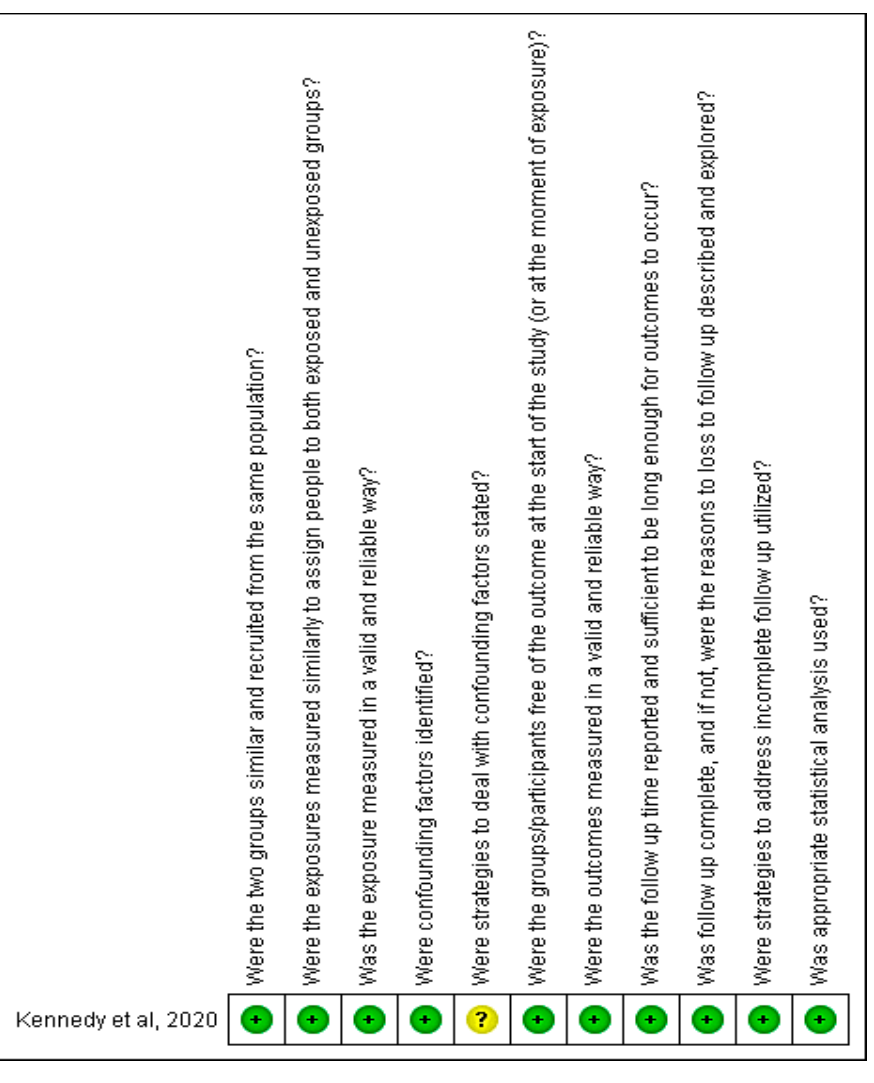
Figure 4. Analysis of the risk of bias for the cohort study included in the review.